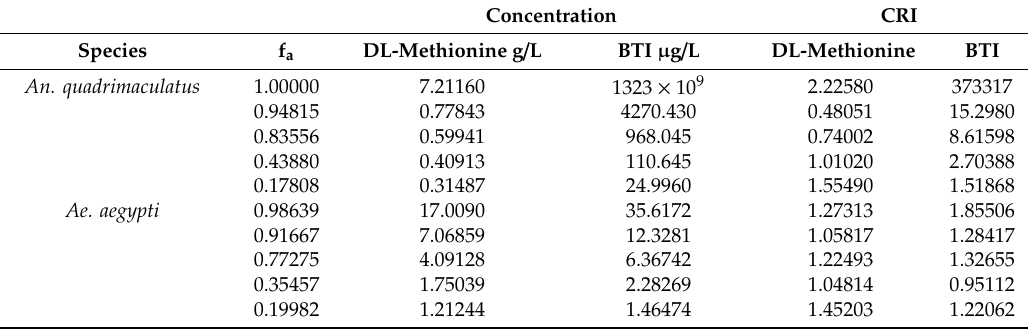
Table 4. Concentration reduction index ( CRI ) of DL-methionine and Bacillus thuringiensis subspecies israelensis (BTI) for Anopheles quadrimaculatus (n = 4) and Aedes aegypti (n = 6). Assays were conducted for 48 h in glass jars. Concentrations of each active ingredient to achieve the lethality fraction ( f a ) of the combined larvicide and the CRI for each active ingredient for each species calculated using the software Compusyn [30]. Concentration CRI Species f a DL-Methionine g / L BTI µ g / L DL-Methionine BTI An. quadrimaculatus 1.00000 7.21160 1323 × 10